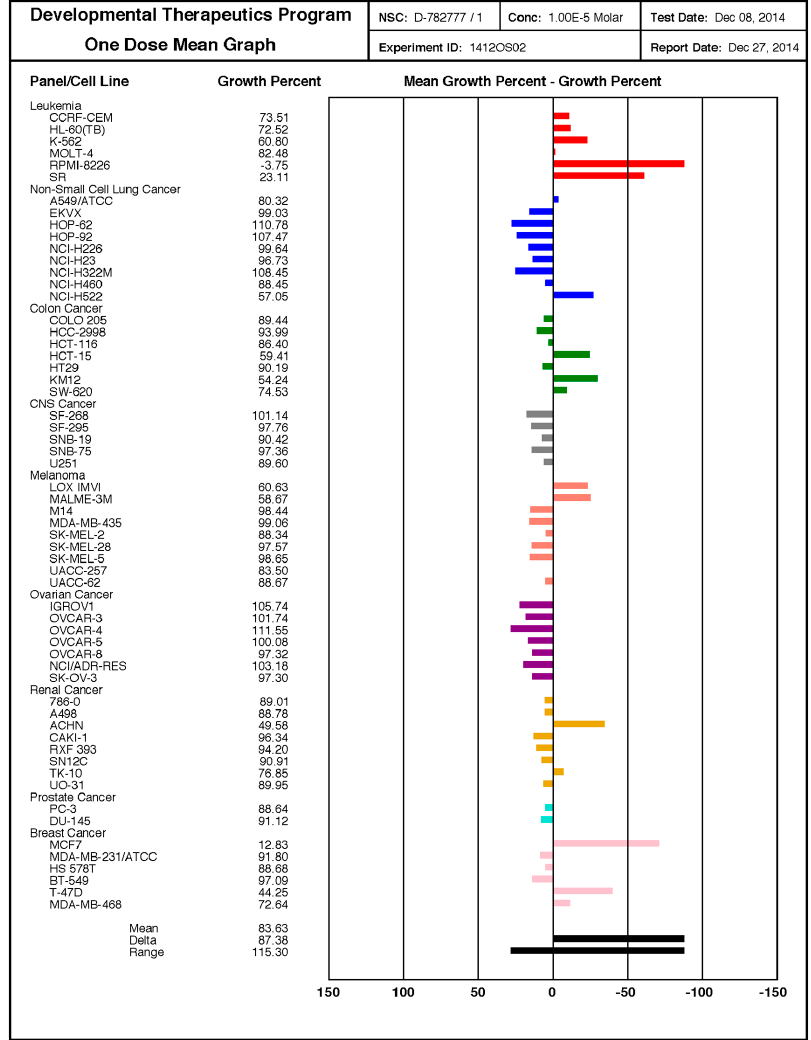
Figure 4. SF102 is active in 60 cancer cell lines of the NCI-60 cell panel . These studies were performed by the Services of the Discovery & Developmental Therapeutics Program at the NIH (http://dtp.cancer.gov). SF102 was applied at a single dose (10 µM) to the 60 cancer cell lines representing leukemia, melanoma, non-small-cell lung carcinoma, and cancers of the brain, ovary, breast, colon, kidney, and prostate, as indicated. The growth inhibition (values between 0 and 100) and lethality (values less than 0) were measured. For example, a value of 100 means no growth inhibition. A value of 40 means 60% growth inhibition. A value of 0 means no net growth over the course of the experiment. A value of − 40 means 40% lethality. A value of − 100 means all cells are dead.